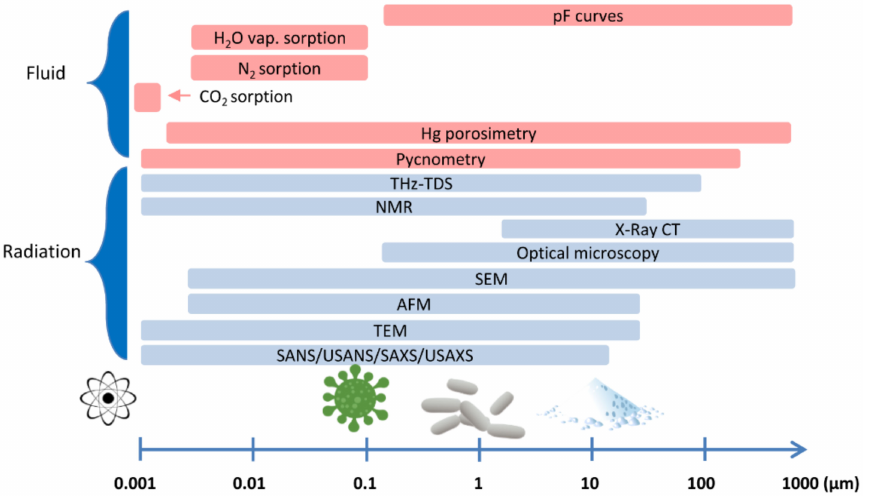
Figure 2. Comparison of the measurement range of different analytical methods used to characterize porosity and pore size distribution. The X -axis is represented with a logarithmic